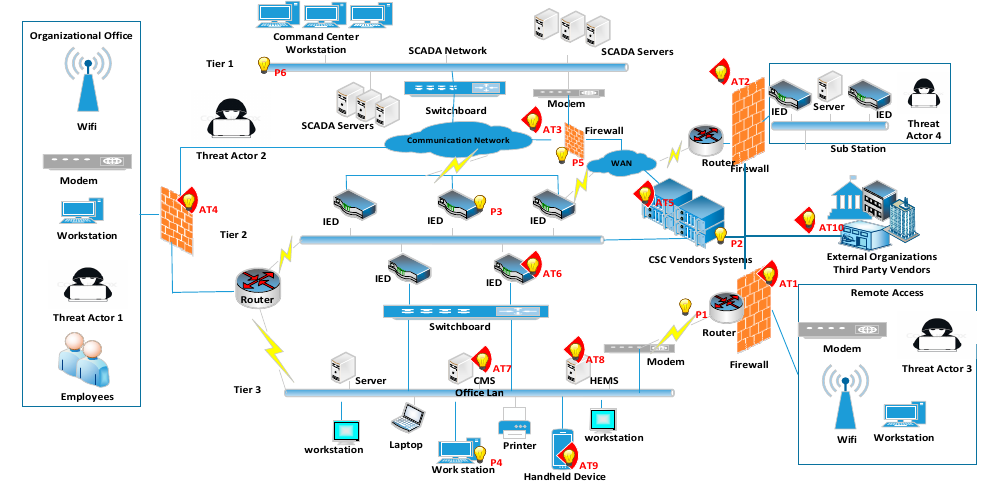
Figure 4. Structure of smart grid CSC and potential security threats.